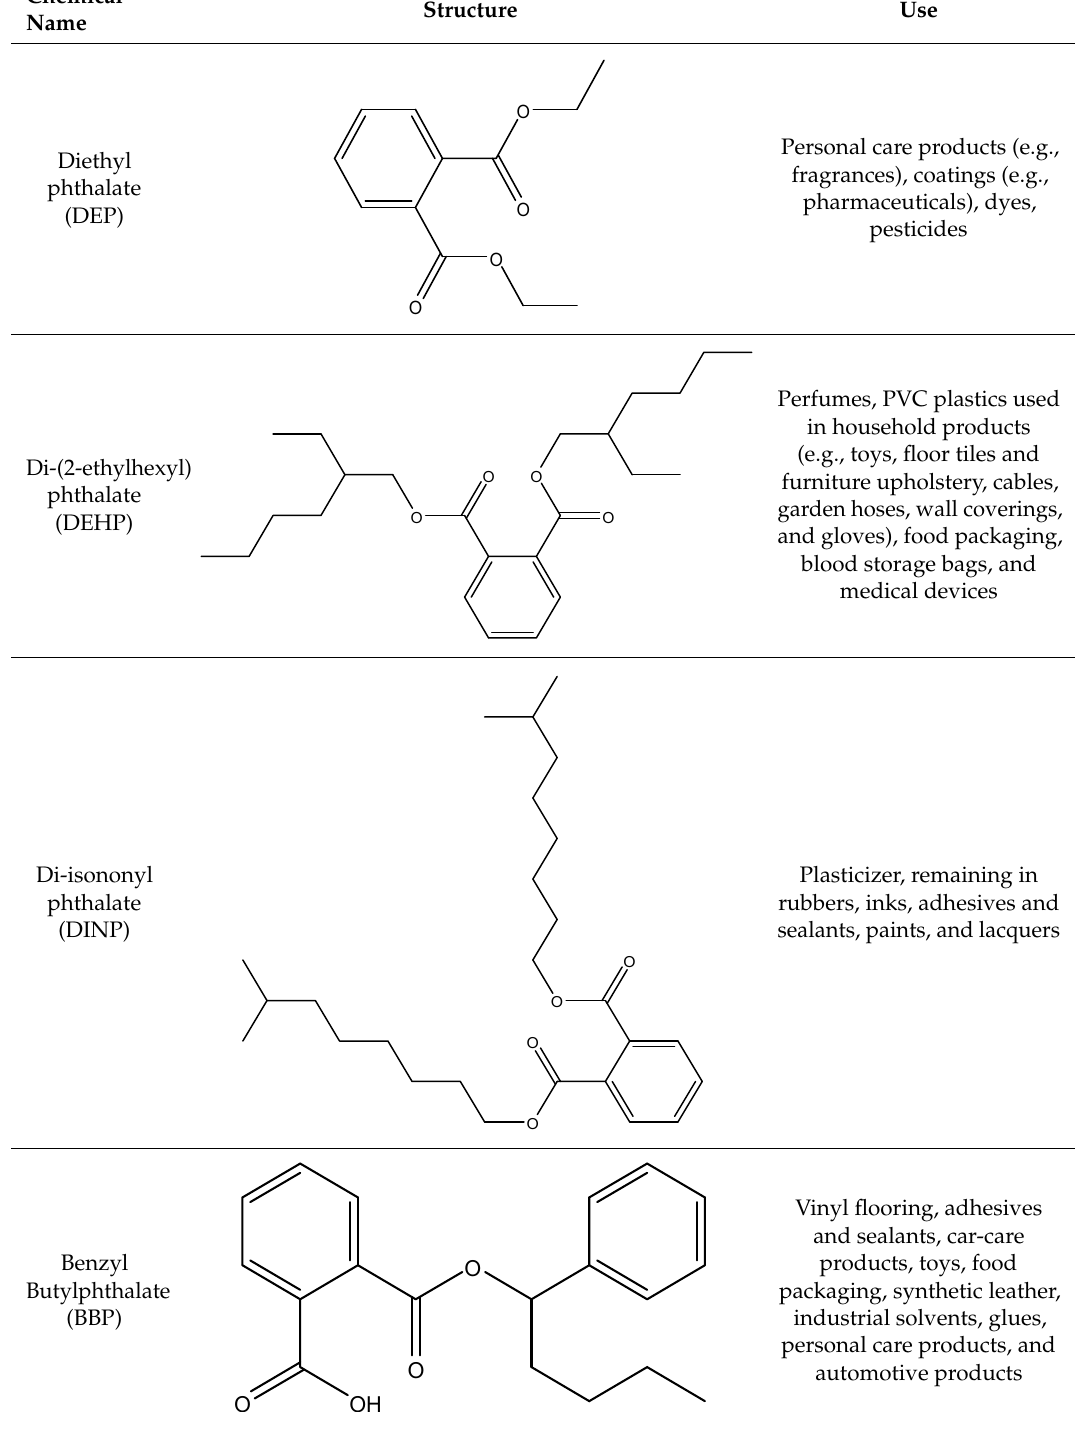
Table 1. Chemical structure of common phthalates and their main applications.